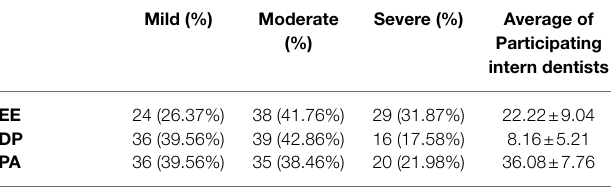
TABLE 3 | Maslach Burnout Inventory subscale scores for intern